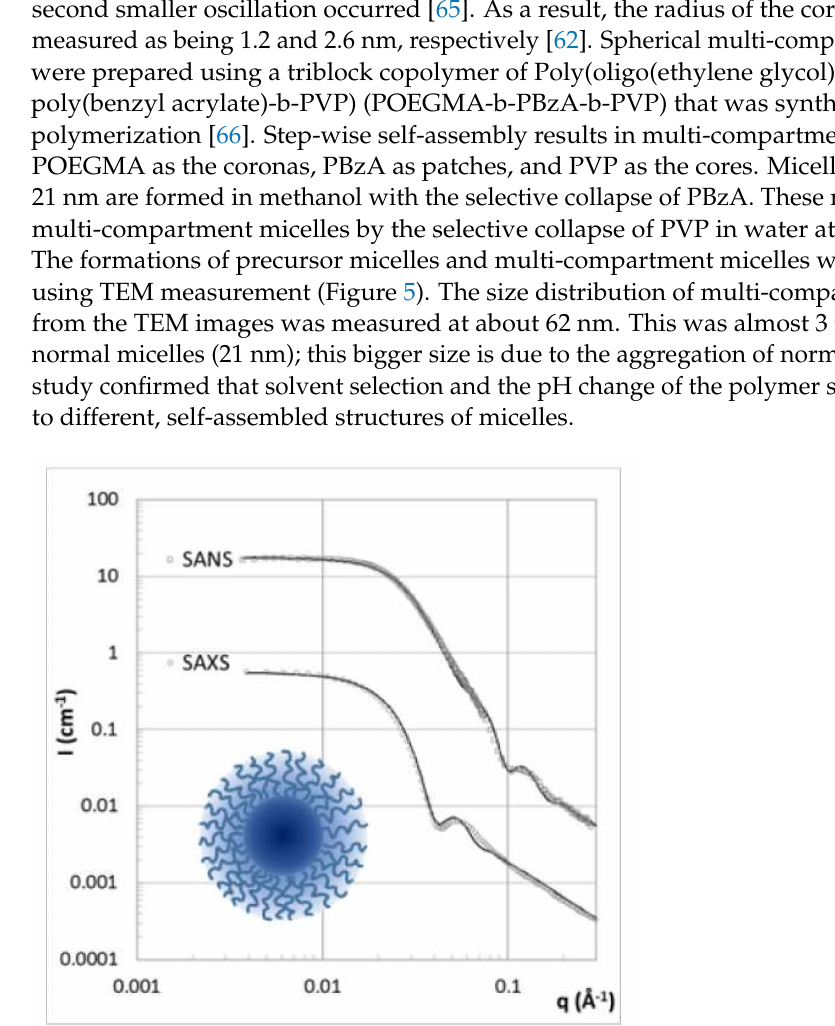
Figure 4. The fit of the SAXS intensity profile of Pluronic (F127) (1%) and linalool (0.2%) solutions in D 2 O at 37 ◦ C. Reprinted with permission from [65]. Copyright 2018 American Chemical